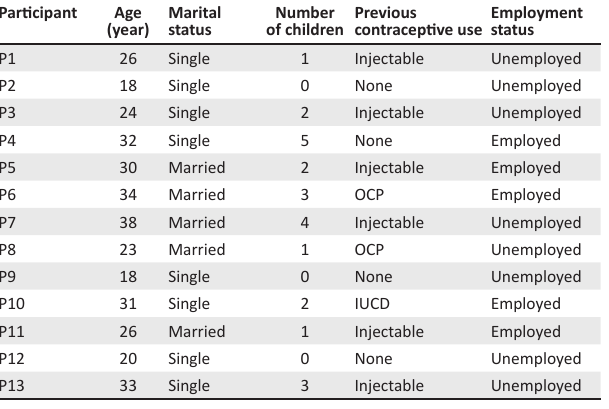
FIGURE 1: Integration of Supporting quotes from participants